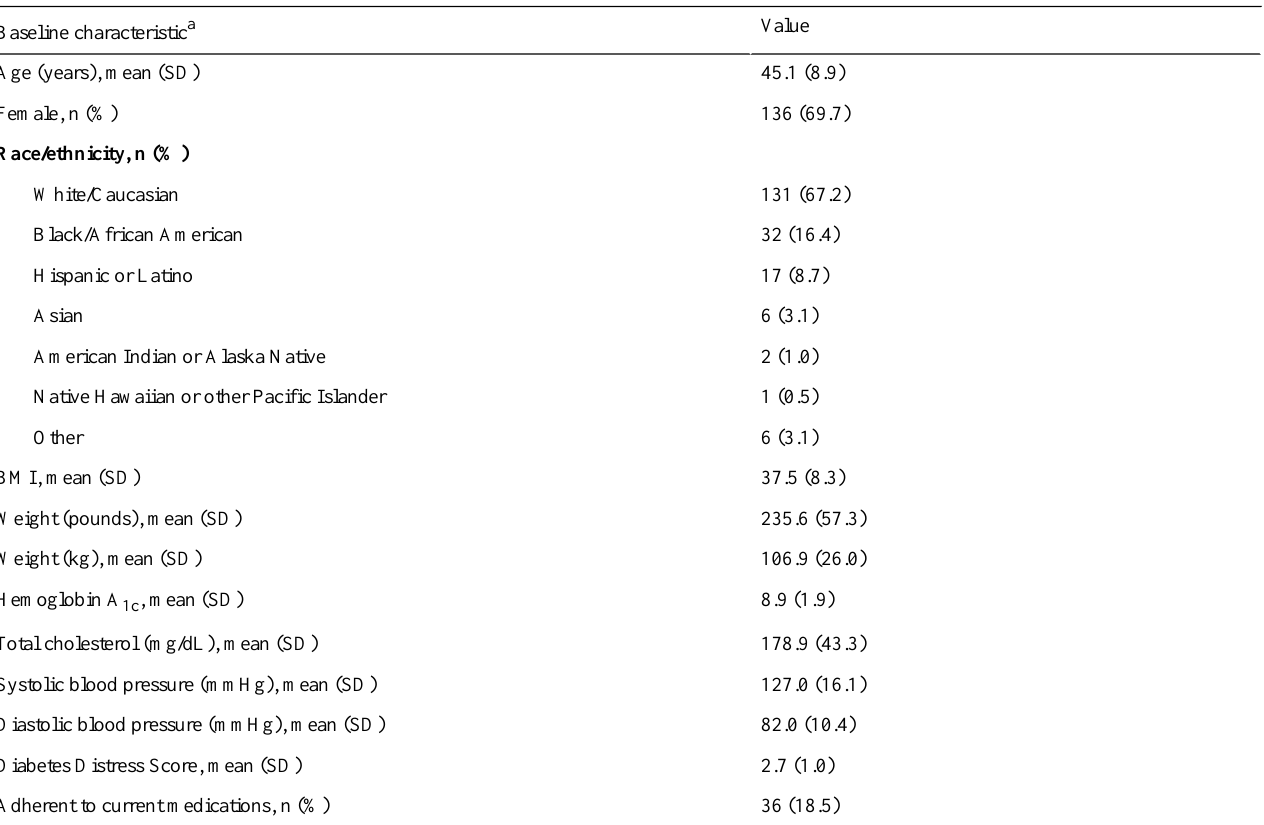
Table 1. Baseline participant characteristics